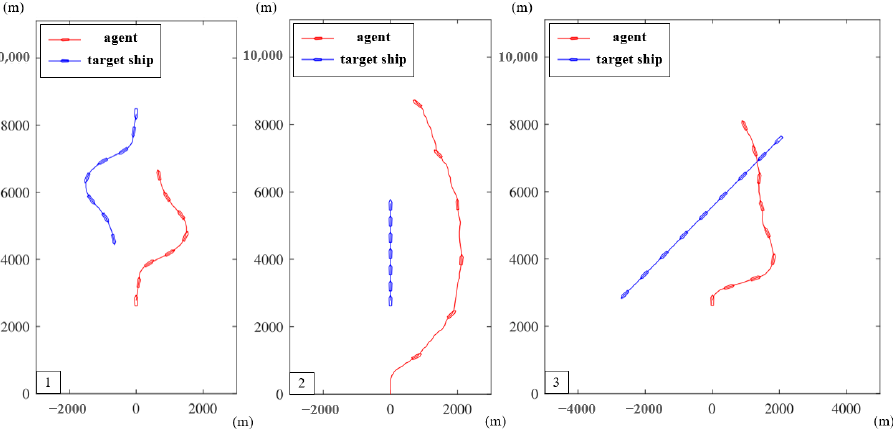
Figure 12. Simulation results for two-ship-collision avoidance (1: head-on; 2: overtaking; 3: cross- ing).